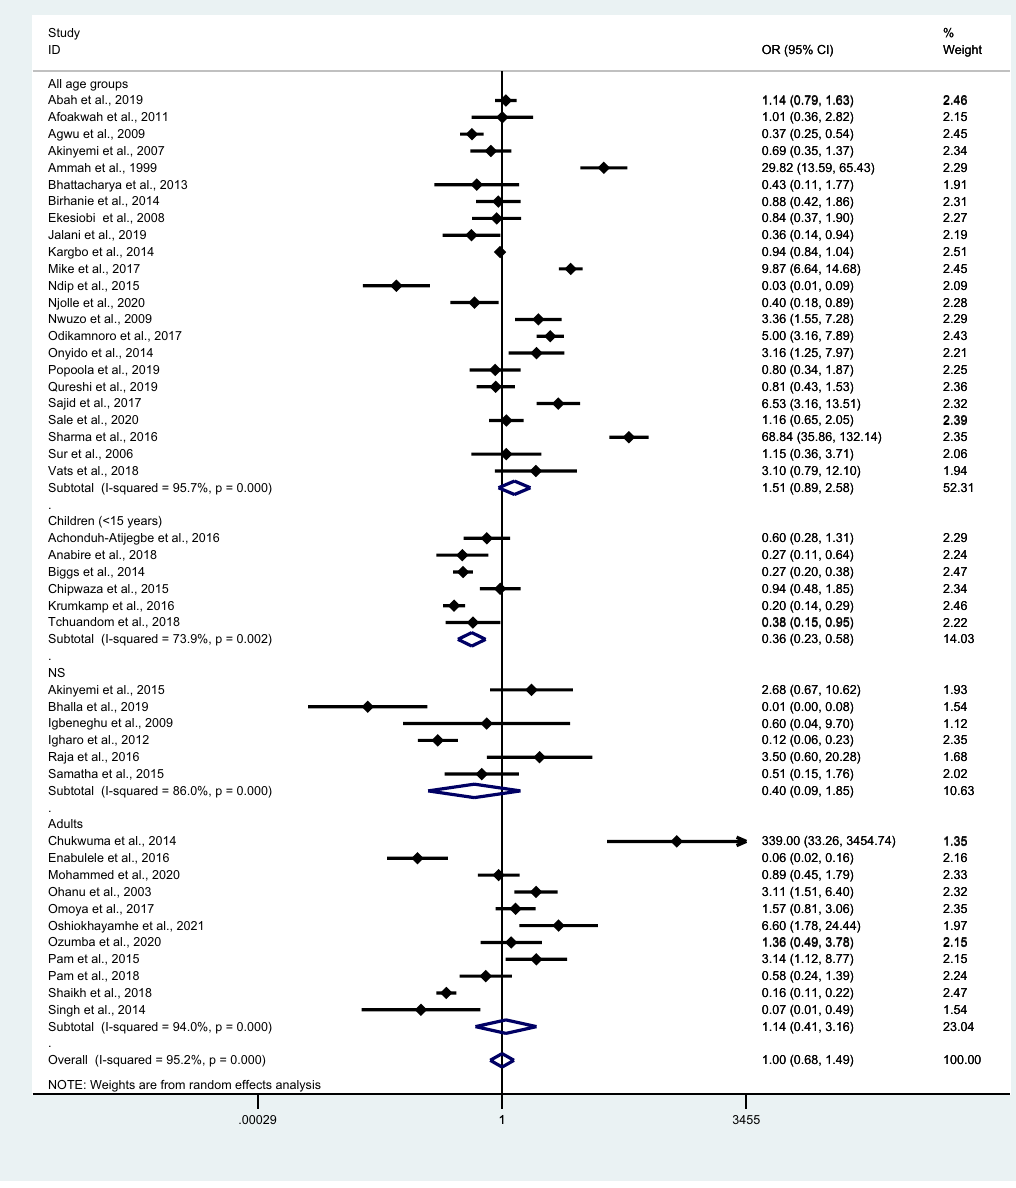
Figure 24. Probability of Plasmodium spp. and Salmonella spp. co-infections. OR odds ratio, CI confidence interval, NS not